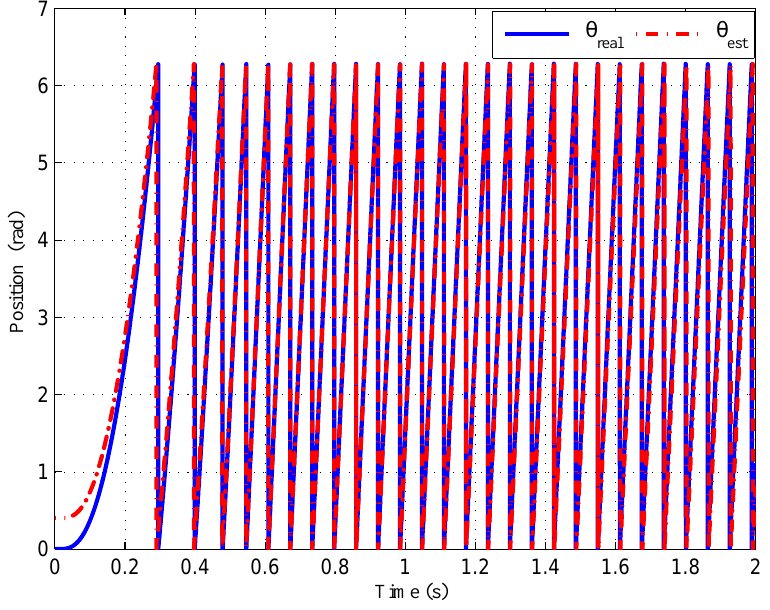
Figure 4. Observed and real position (nominal